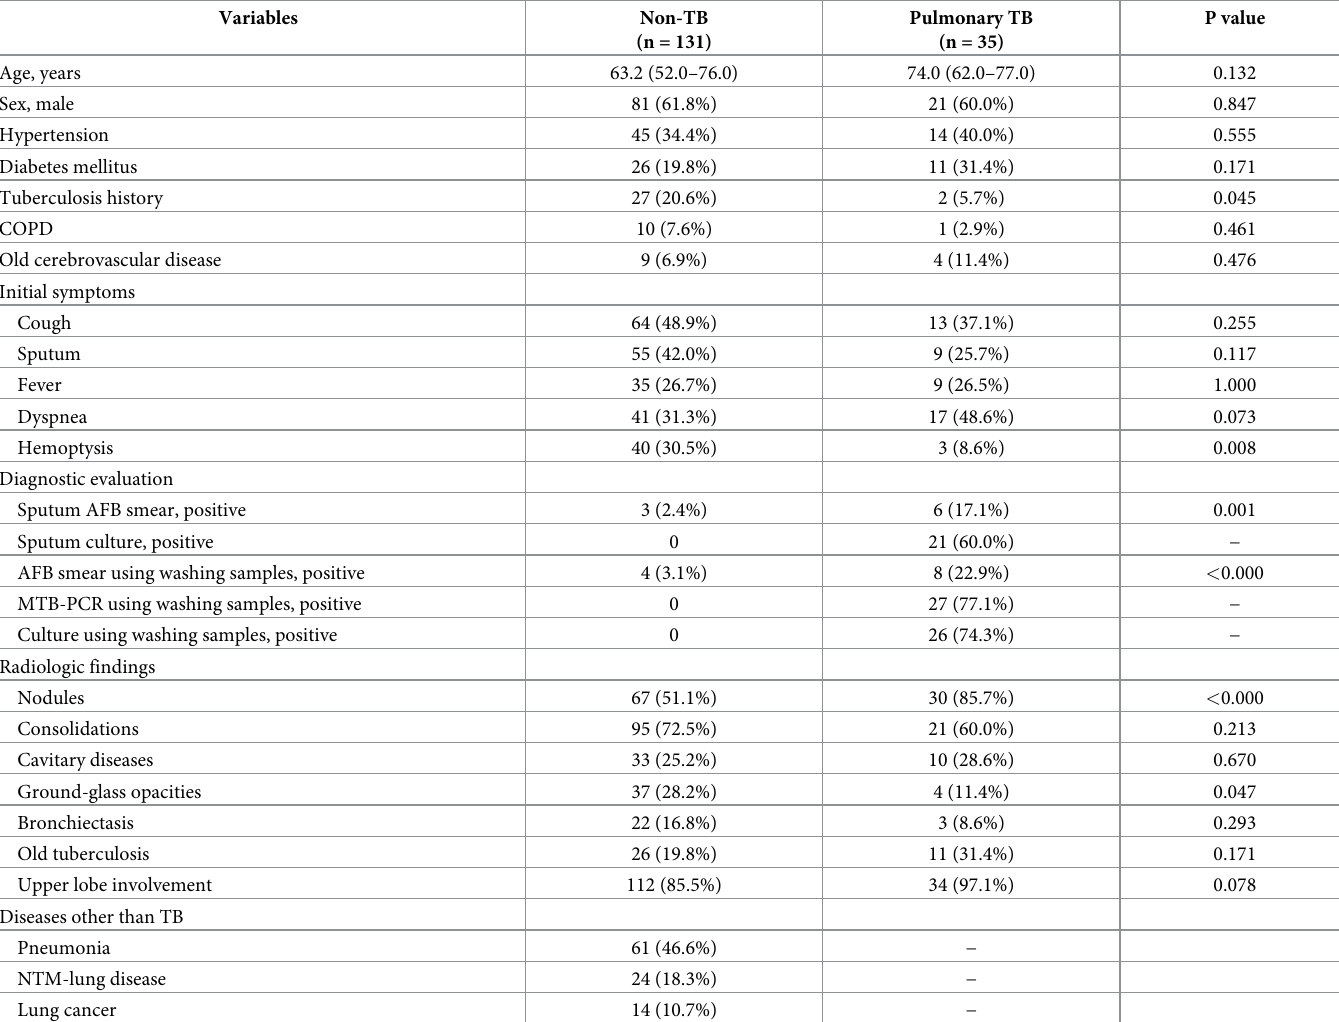
Table 1. Patients’ baseline characteristics.